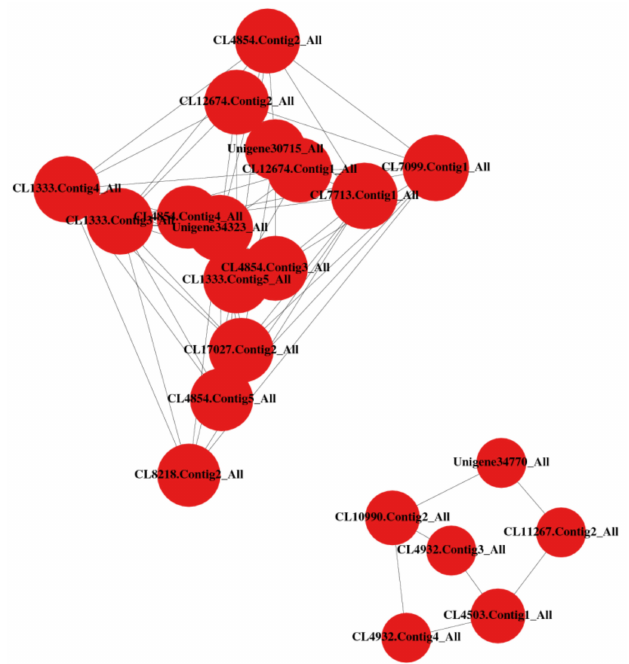
Figure 7. A representative of the most upregulated and highest protein interaction data in salt-48h vs. salt-24h. The larger the circle, the denser the relationship. The CL at the beginning of a name denotes a cluster and is followed by the number of the unigene